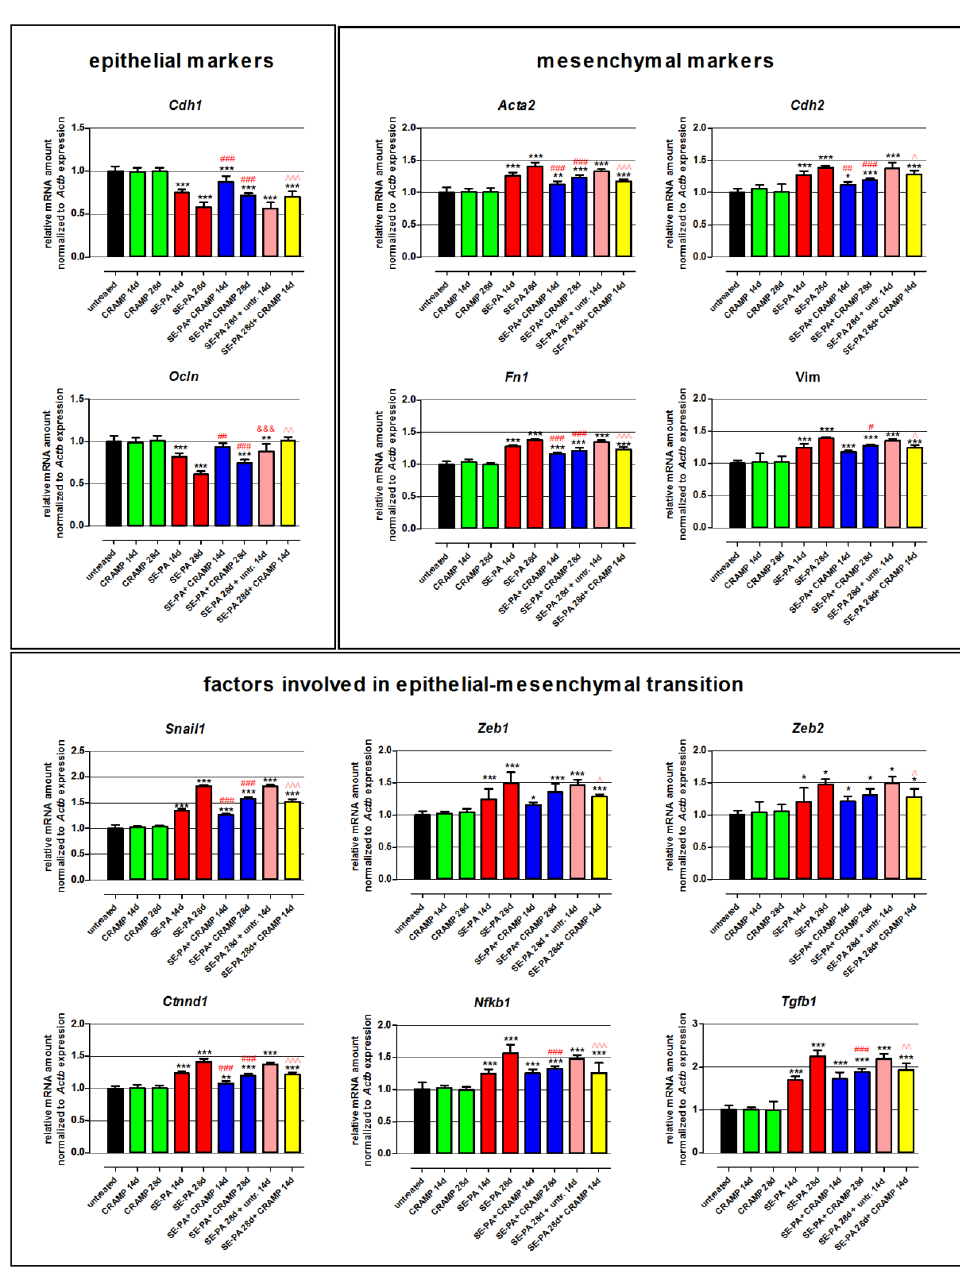
Figure 1. Alterations in the expression of genes involved in epithelial–mesenchymal transition (EMT) in response to cathelicidin (CRAMP) and/or saline extract of Pantoea agglomerans (SE-PA) treatment. Expression of gene coding epithelial markers, mesenchymal markers, and factors involved in epithelial – mesenchymal transition. Gene expression was investigated in homogenates of lungs collected from untreated mice (control) and animals exposed to investigated compounds for 14, 28, or 42 days using the real-time PCR method. Results are presented as the mean of relative mRNA amount ± SD. Each research group consisted of 8 mice: 6 treated and 2 untreated animals. Samples were collected from all animals and analyzed in 3 replications. Statistical significance from a one- way ANOVA test followed by Tukey’s post hoc test: compared to untreated mice at p < 0.05 (*), p < 0.01 (**), p < 0.001 (***); SE-PA + CRAMP 14 d/28 d vs. SE-PA 14 d/28 d (comparison within corresponding time points) at p < 0.05 (#), p < 0.01 (##), p < 0.001 (###); SE-PA 28 d + CRAMP 14 d vs. SE-PA 28 d + untreated 14 d at p < 0.05 (ˆ), p < 0.01 (ˆˆ), p < 0.001 (ˆˆˆ); SE-PA 28 d + untreated 14 d vs. SE-PA 28 d at p < 0.001